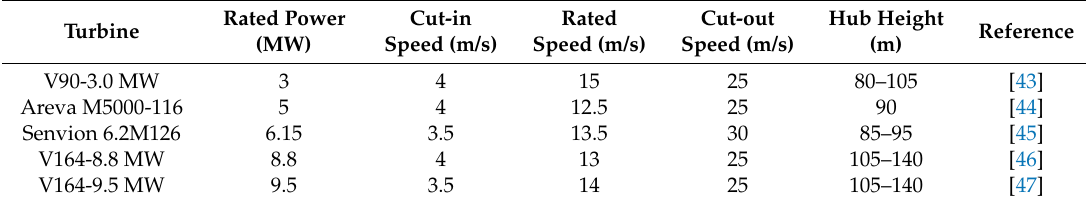
Table 2. Technical specifications for the technologies